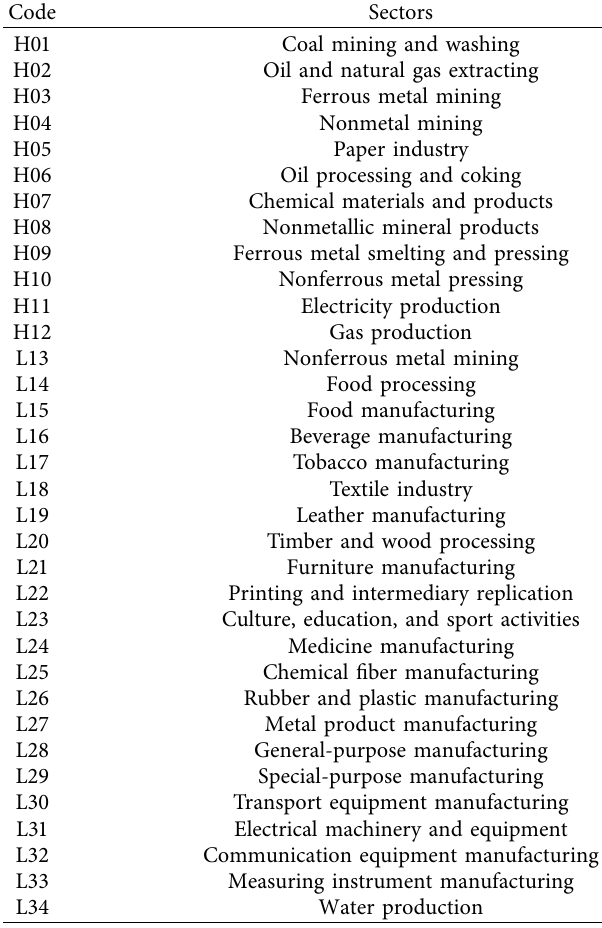
Table 1: China’s industrial sectors and group